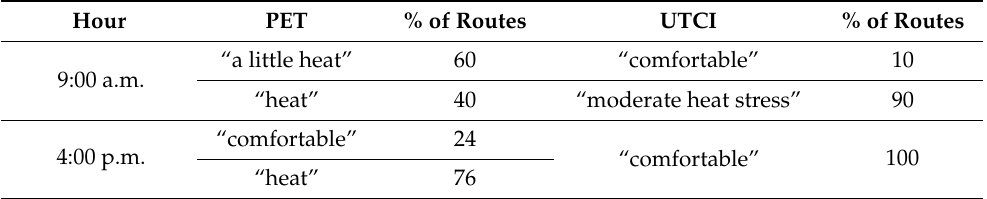
Figure 9. Spatial variability of PET and UTCI indices along bike paths in Balneário Camboriú/SC. Source: Authors (2022). Table 1. Percentage of routes according to PET and UTCI interpretive